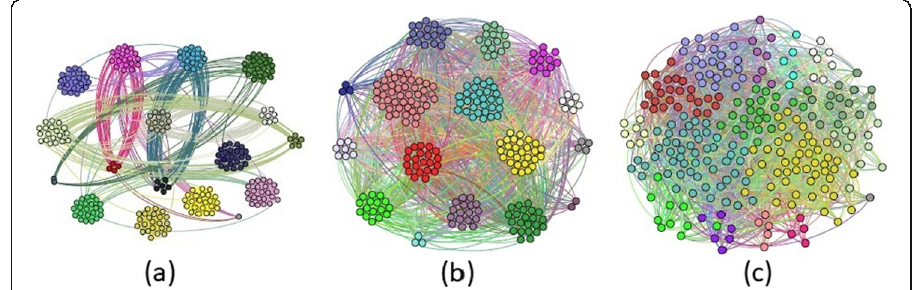
Fig. 1 Results of our clustering algorithm corresponding to LFR graphs with N = 250 and ( a ) μ = 0.1 , ( b ) μ = 0.3 and ( c ) μ =